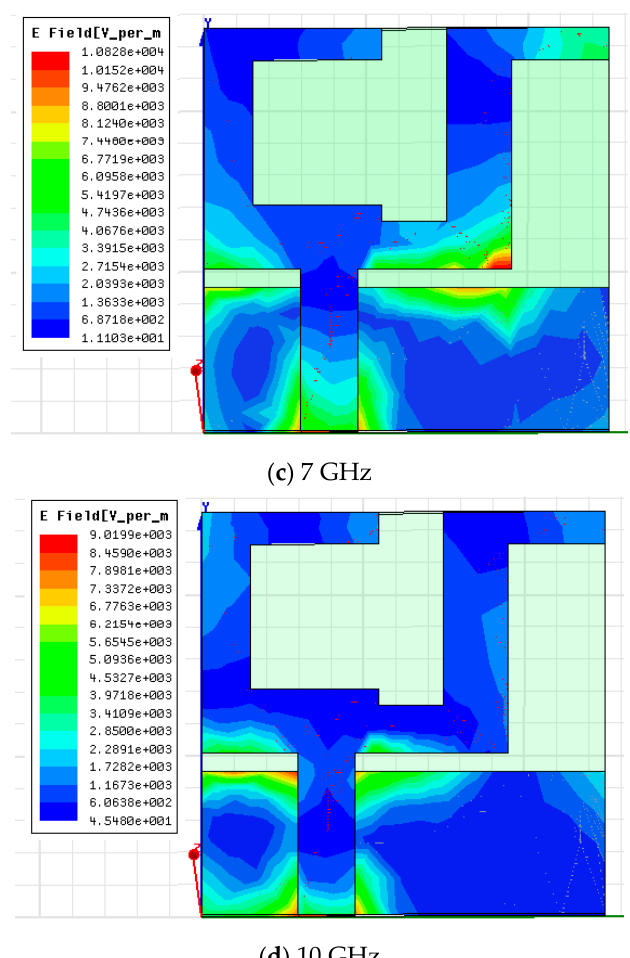
Figure 15. Current distributions at 7 GHz ( a ), 4 GHz ( b ), 7 GHz ( c ) and 10 GHz ( d ) frequencies.